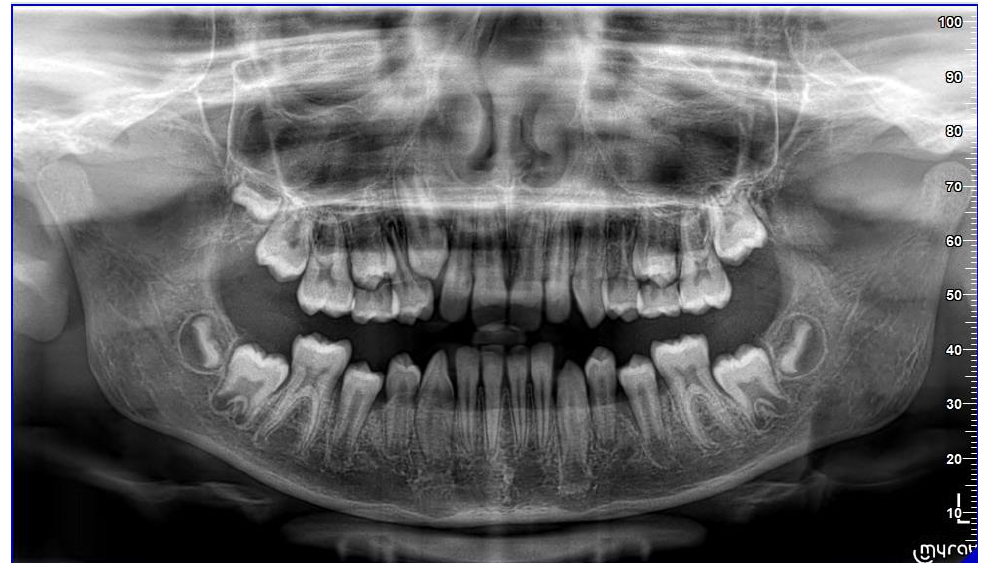
Figure 7. Pre-treatment Orthopantomography.